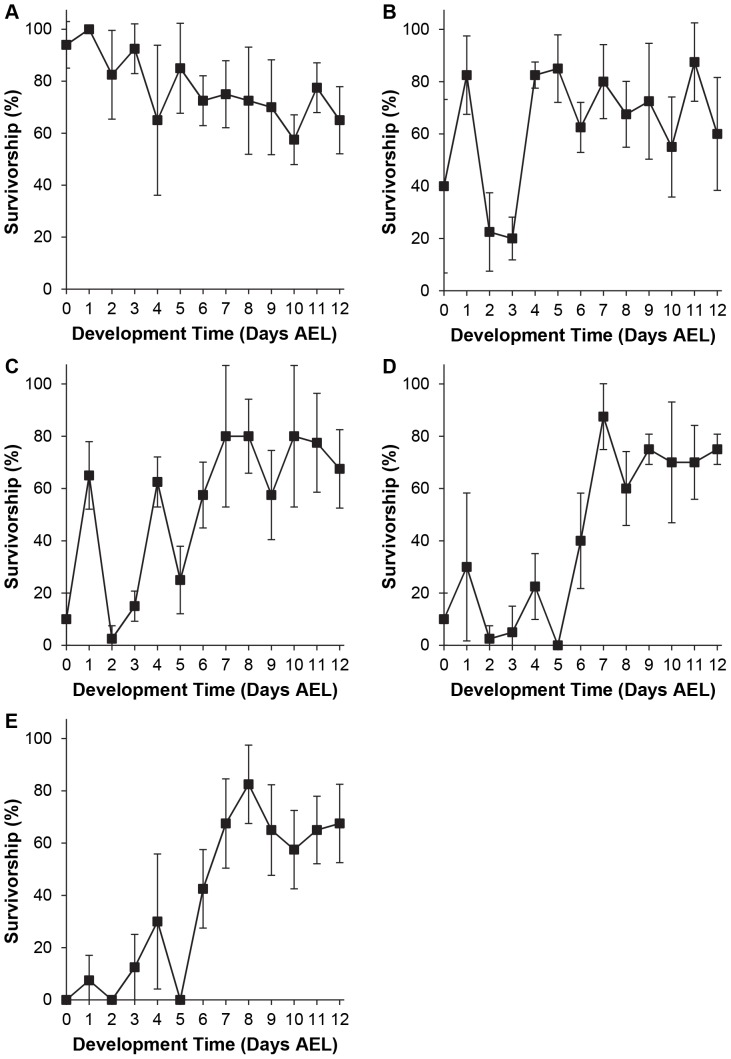
Survivorship of y w flies at different developmental stages after 0–4 d at 4°C.First instar larvae (10/vial) were collected from apple juice/agar plates up to 1 d after egg laying (AEL) and allowed to develop until 1–12 d AEL. Parental flies deposited ≥10 embryos (0 d AEL) directly onto the food surface for ∼2 h. The embryos and larvae were then placed simultaneously at 4°C for (A) 0 d, (B) 1 d, (C) 2 d, (D) 3 d or (E) 4 d. Results (mean ± S.D.; n = 4–5 vials for each development and exposure time) are percentages of fully eclosed adults after 14 d at 25°C, in addition to time spent at 4°C. For adults that eclosed prior to cold stress (none 0–9 d AEL and almost all flies 10–12 d AEL), the results are numbers that recovered after incubation at 4°C.